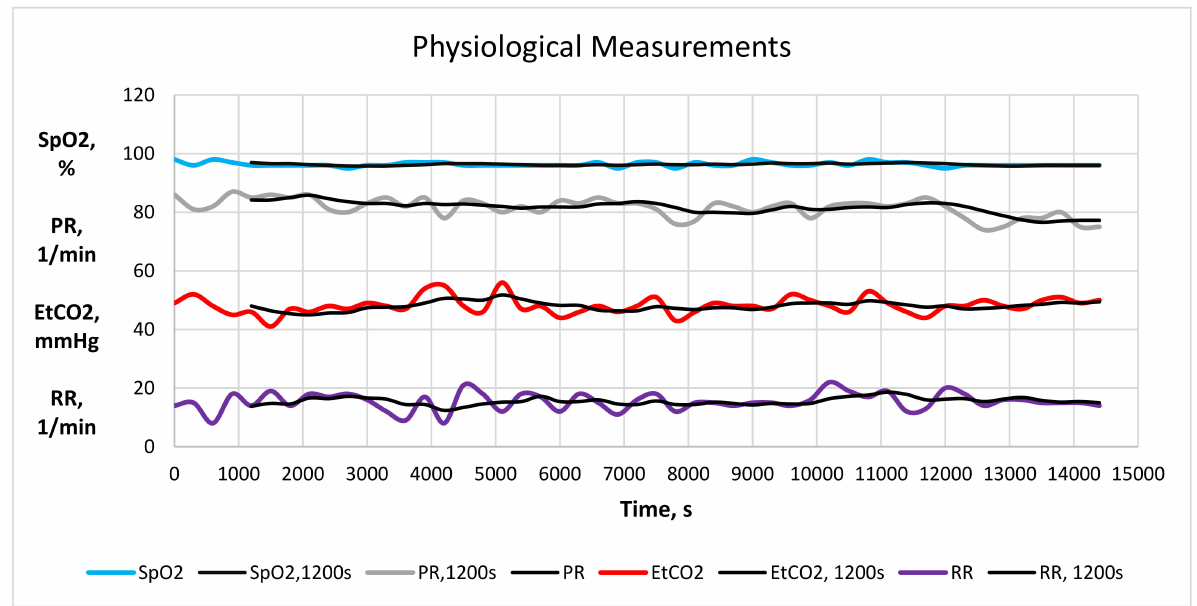
Figure 21. Results for the monitored physiological parameters (oxygen saturation pressure (SpO2), pulse rate (PR), end-tidal CO 2 (EtCO2), respiration rate (RR)) with the evolution curves for each parameter, time-averaged for 1200 s (black